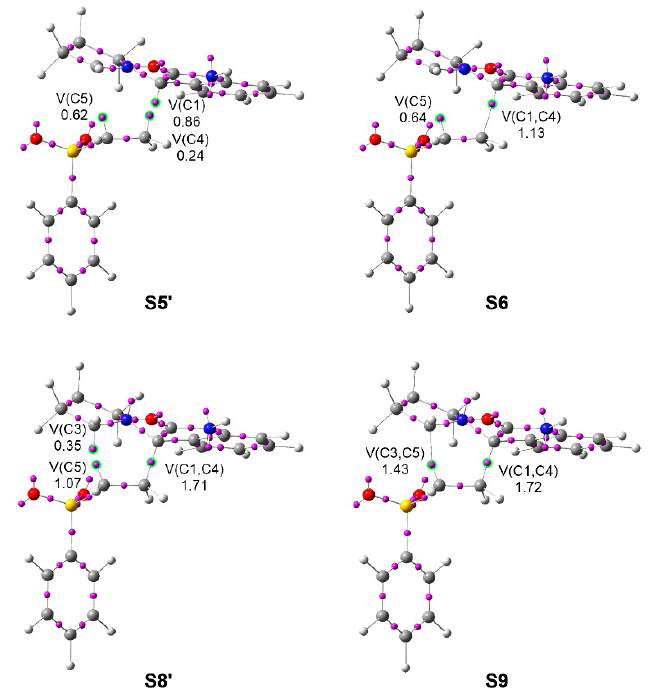
Figure 4. ELF attractor positions and populations of the ELF valence basins involved in the C1–C4 and C3–C5 bond formation at S6 and S9 , respectively, and the structures immediately before, along the meta/endo path of the pmr-type 32CA reaction between AY 22 with vinyl sulphone 20 . Populations are given in average number of electrons, e.